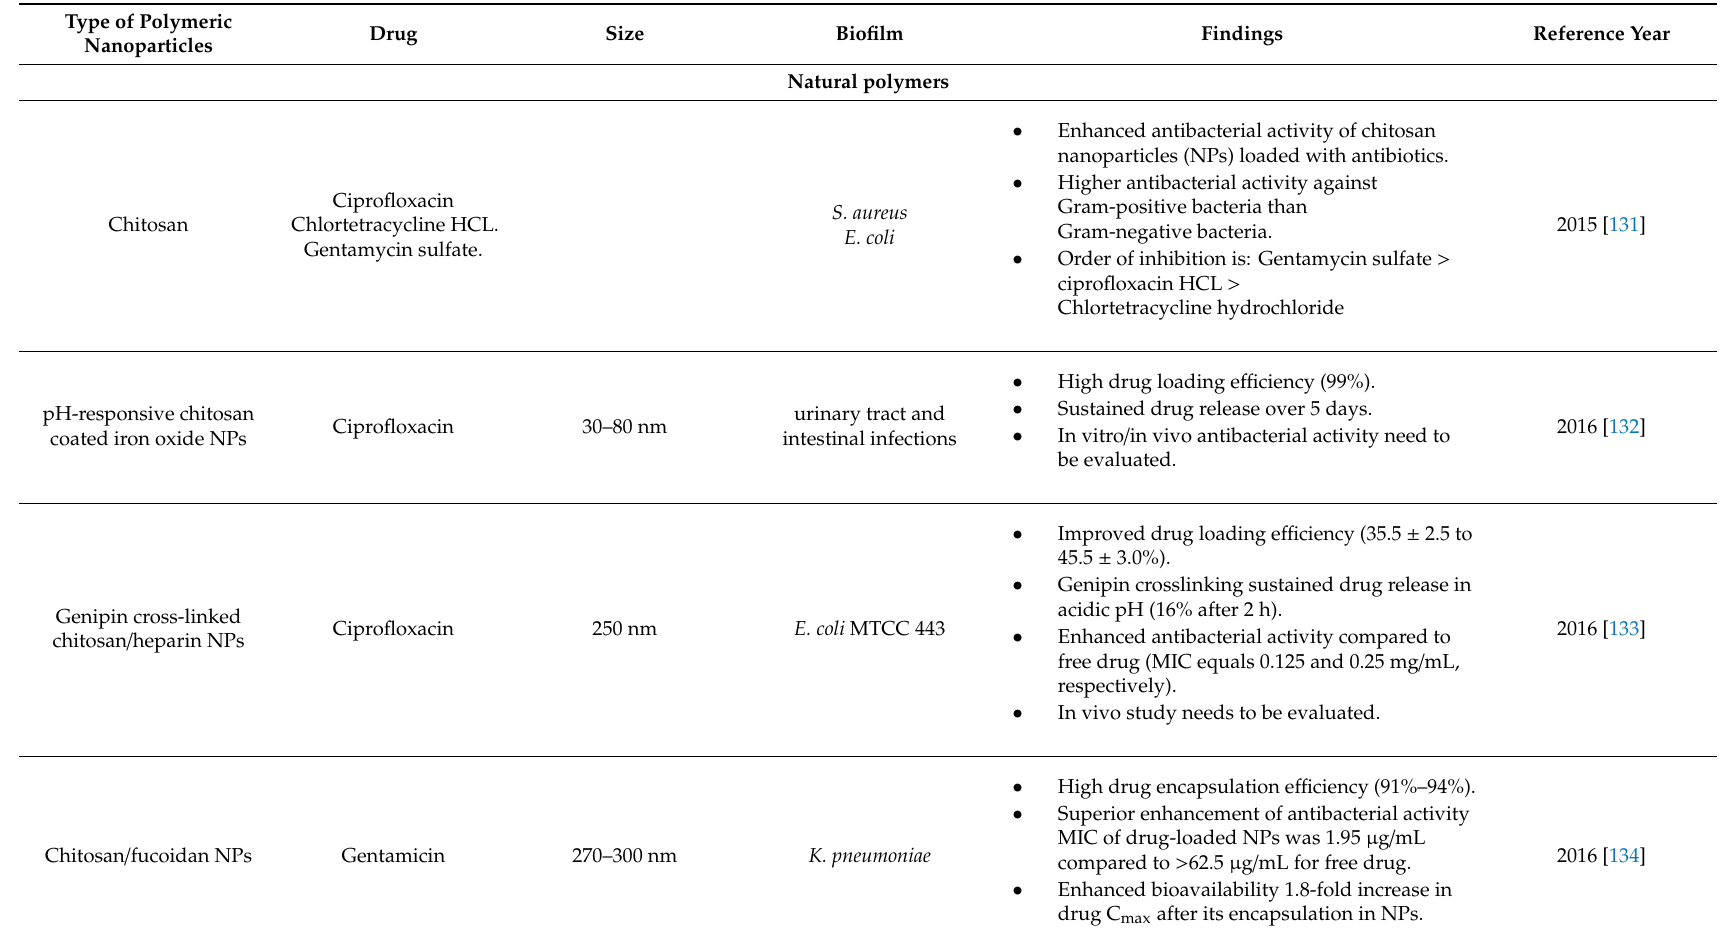
Table 4. Examples on recent studies on polymeric nanoparticles against bacterial